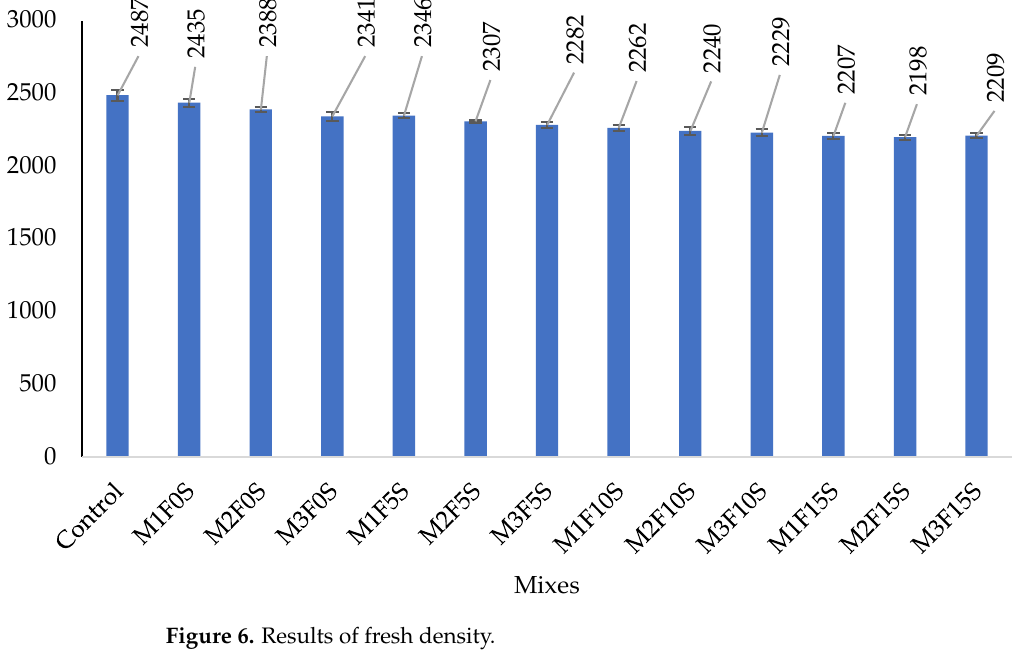
Figure 6. Results of fresh density.